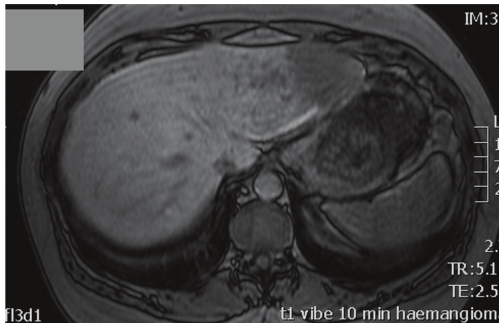
Figure 2: MRI scan showing abnormal areas in segments two, three, and four of the